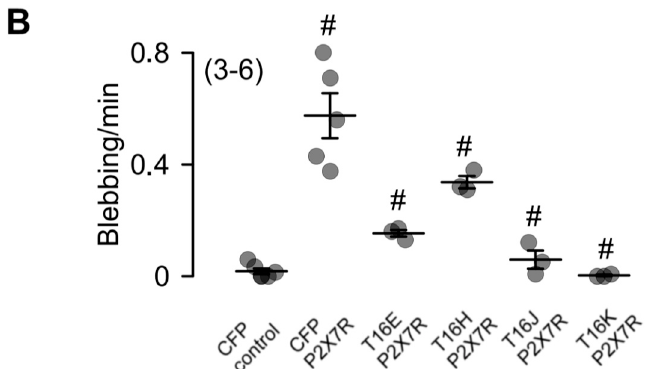
Figure 7. Reduced P2X7R-dependent membrane blebbing in cells expressing TMEM16 paralogs. ( A ) HEK293 cells were transfected with CFP (control), P2X7 receptor (P2X7R) and CFP or P2X7R and TMEM16 paralogs in a ratio of 4:1. Membrane blebbing was stimulated by 5 mM ATP. Blebbing events were counted in a time frame of 15 min after addition of ATP. Bar 20 µ m. White arrows indicate blebbing events. ( B ) Summary of membrane blebbing rate (blebbing / min) of HEK293 cells expressing CFP (control), P2X7R and CFP or P2X7R and TMEM16 paralogs. Mean ± SEM (Number of